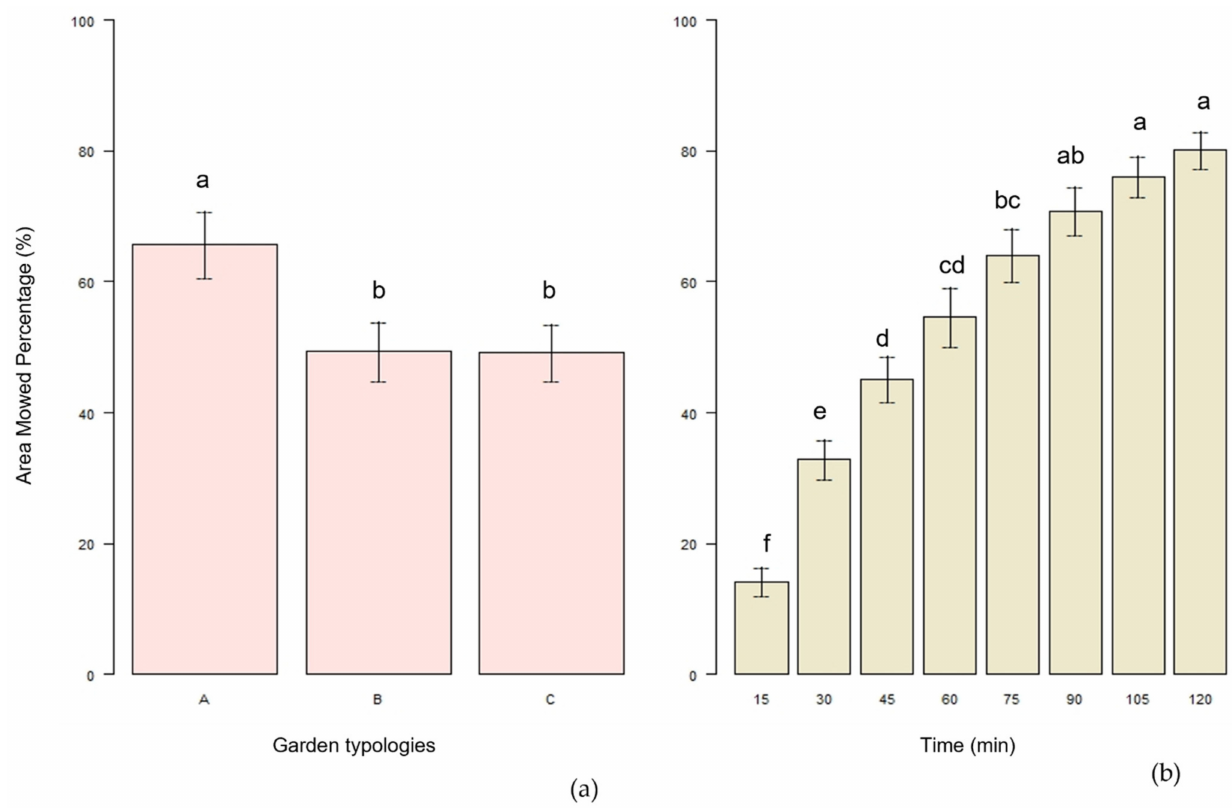
Figure 5. Mean percentage of area mowed for garden typology ( a ) and time intervals. ( b ) Vertical bars represent the standard errors. Different letters on the same plot indicate significant difference at p < 0.05 (LSD